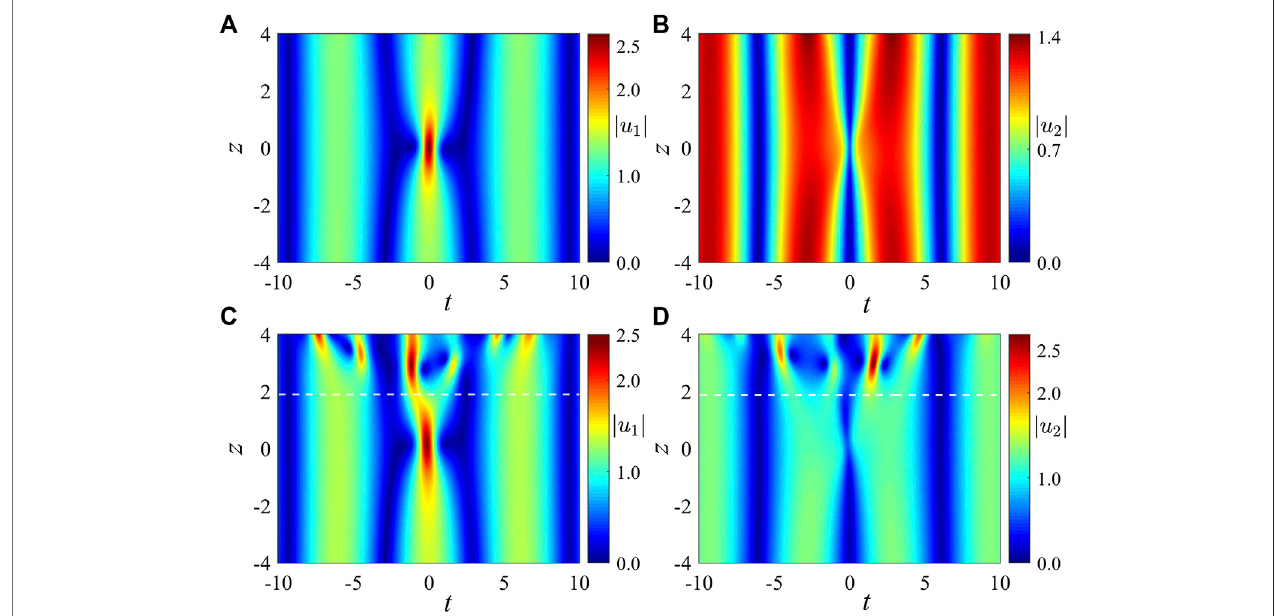
(cid:5)(cid:5) √ / 9, ω (cid:2) − 40 / 81, 5 1